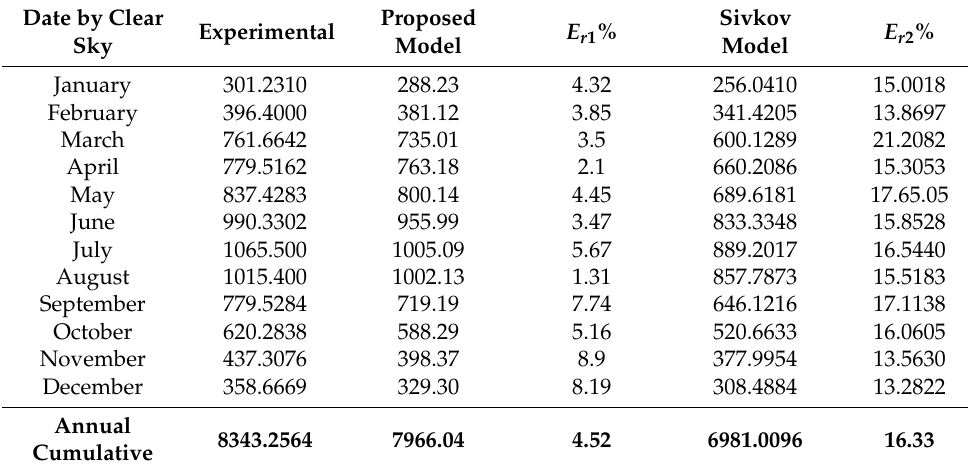
Table 11. The results for Tlemcen (MJ/m 2